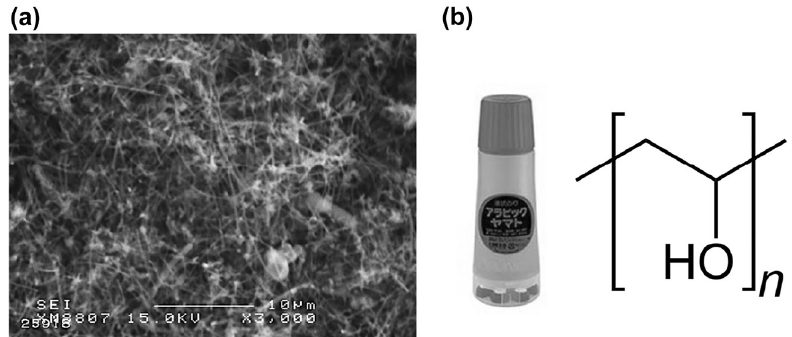
Figure 1. ( a ) SEM image of VGCFs, and ( b ) image and molecular structure of PVA.